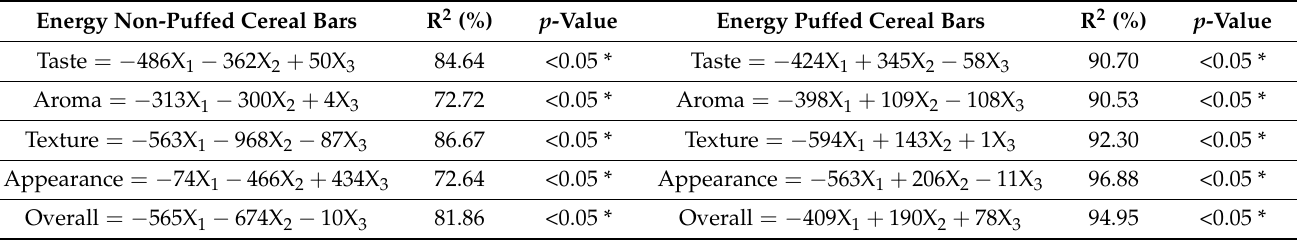
Table 2. Regression equation for the energy cereal bars responses with predicted R-square values.